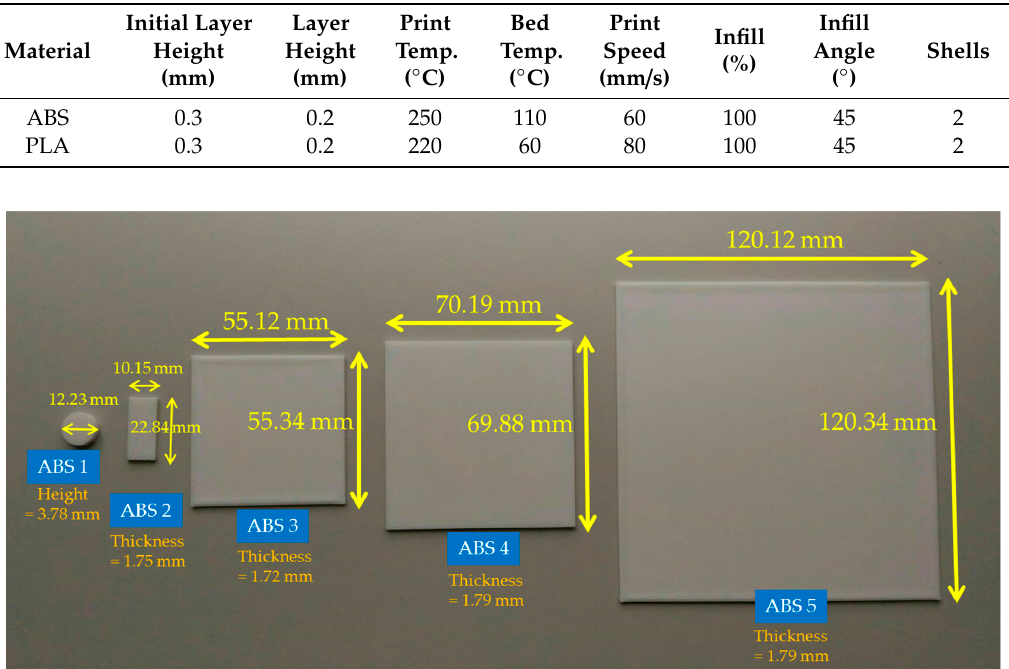
Table 4. Printing parameters for the 3D printing of ABS and PLA samples.